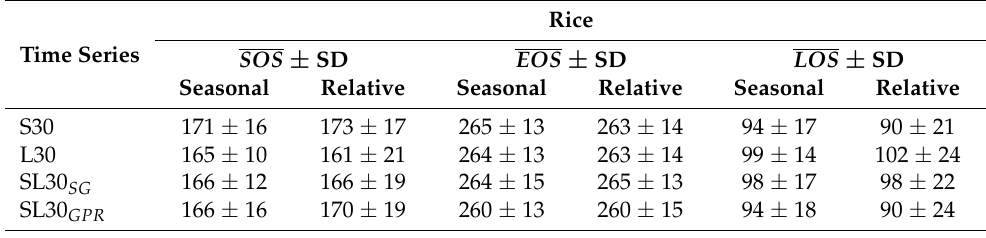
Table 3. Mean value and standard deviation (SD) in days of the key LSP metrics (SOS (DOY), EOS (DOY) and LOS (days)) per crop type and time series collection, comparing the two phenology detec- tion methods (sesonal and relative). An overall standard deviation average in days was calculated from all crop types and each time series